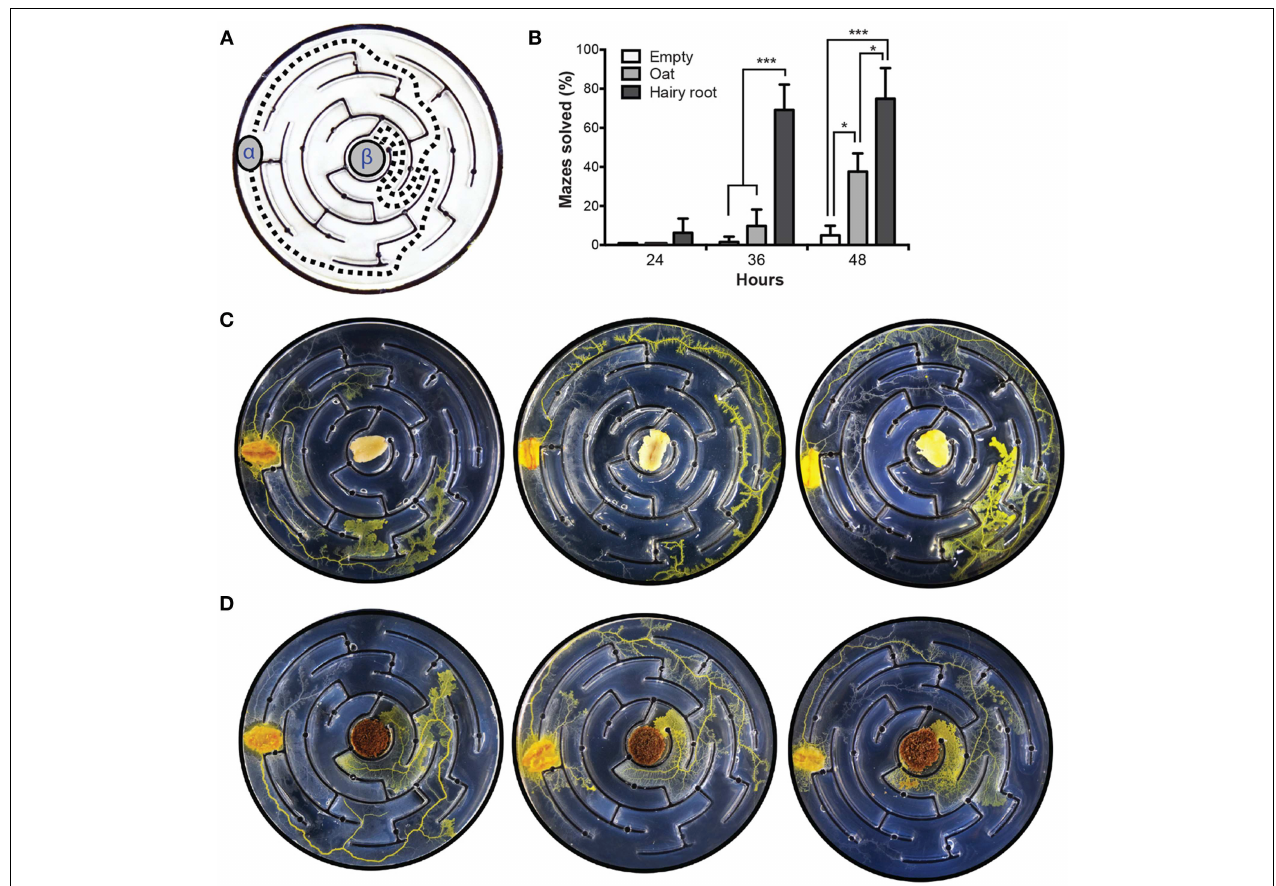
FIGURE 5 | P. polycephalum maze-solving behavioral assay. Plasmodia were inoculated into the most peripheral channel of mazes containing either oat or VoHR5 hairy root in the central chamber. Mazes with empty central chambers were used as a control and completion was scored according to the arrival at the central chamber. (A) Schematic representation of the two optimal shortest paths to maze completion. α , site of plasmodium inoculation, β , central chamber. (B) Hairy root biomass augments the maze-solving behavior of P. polycephalum . After 36h, plasmodia inoculated into control and oat-containing assays completed 1.5 and 10% of the respective mazes whereas plasmodia inoculated into assays containing hairy root achieved 69% maze completion. After 48h, plasmodia completed 5% of control and 38% of oat-containing mazes whereas 75% of hairy root mazes